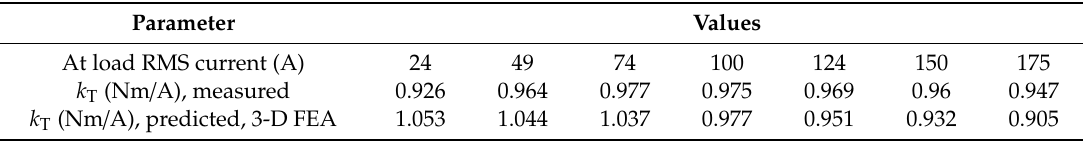
Table 3. Comparison between predicted and measured k T at di ff erent RMS currents at 500 rpm. The results obtained at winding temperature of 55 ◦ C. Parameter